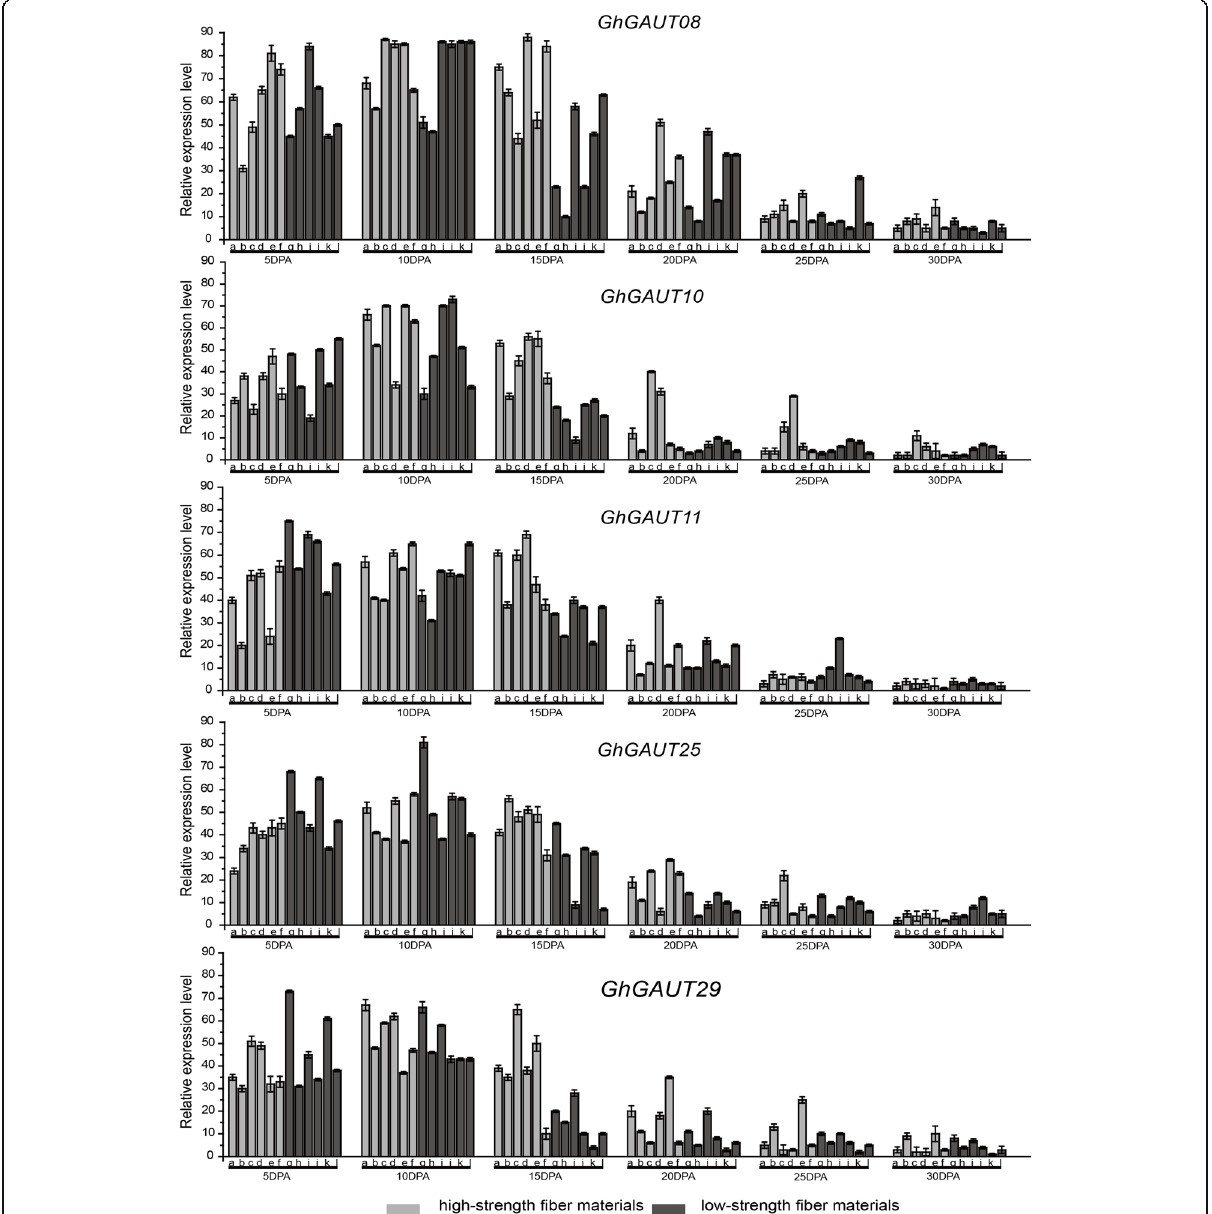
Fig. 5 Analysis of 5 GhGAUT transcript levels in 6 high-strength fiber materials and 6 low-strength fiber materials. (a:0 – 153, b:69262, c:69272, d:69328, e:69327, f:69307, g: sGK9708, h:69312, i:69404, j:69305, k:69412,